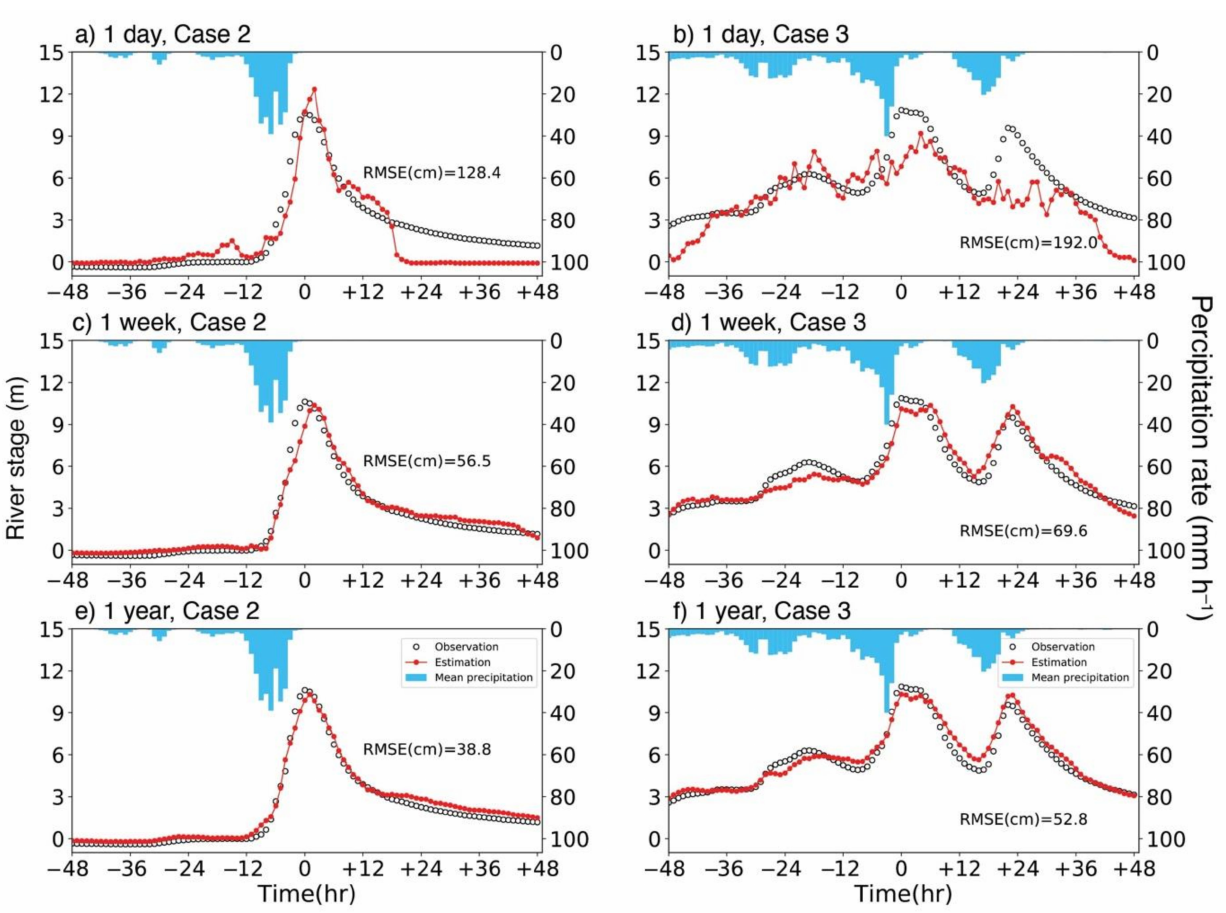
Figure 12. Stage estimates for three lengths of input precipitation time series, examined within 48 h of two flood events. ( a , c , e ) is for case 2 and ( b , d , f ) for case 3. ( a , b ) is for the one-day time series, ( c , d ) for the one-week time series, and ( e , f ) for the one-year time